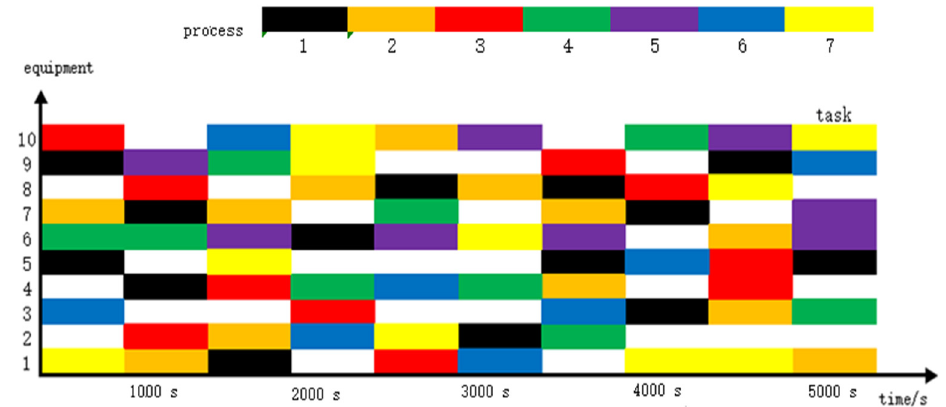
Figure 9. Scheduling scheme for multi-constrained intelligent